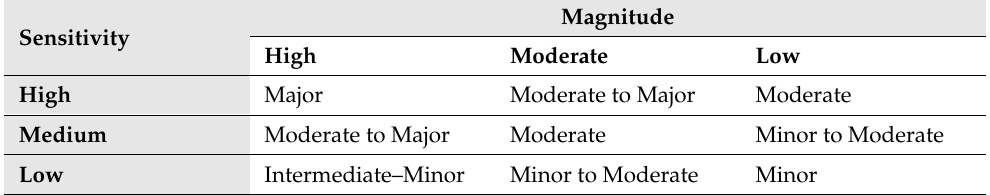
Table 2. Visual Impact Significance